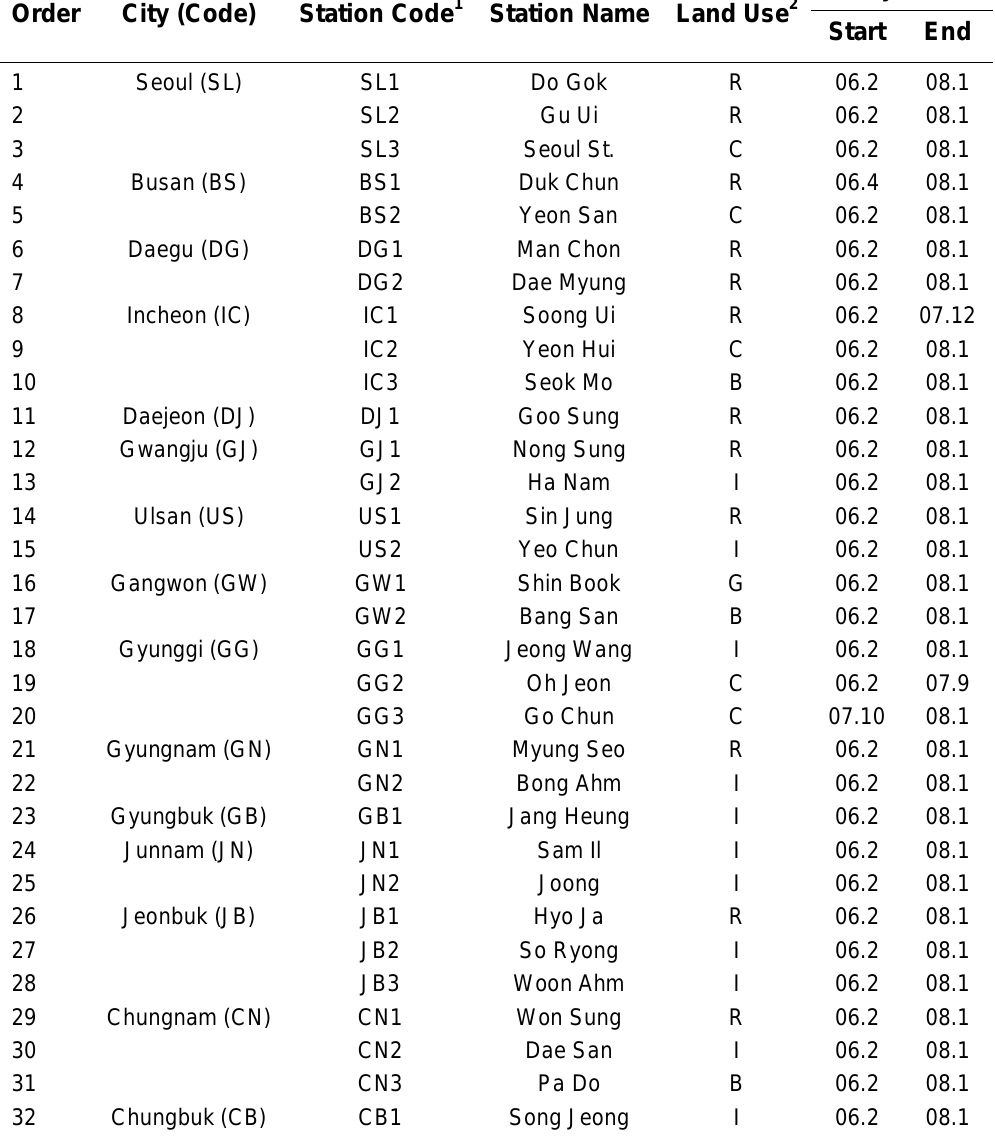
Acronym Codes for Individual Stations in Seven Cities (1 – 15) and Eight Provinces (16 – 32) and the Associated